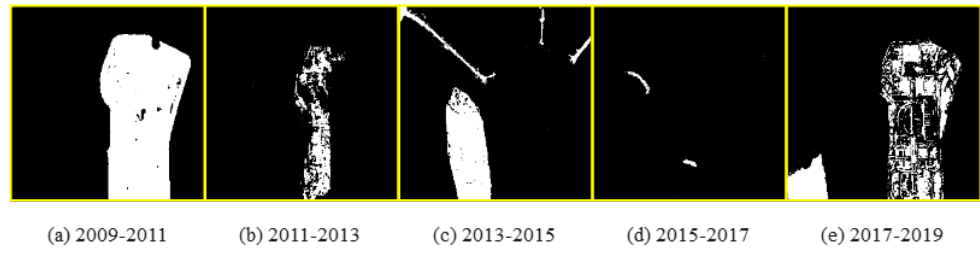
Figure 9. The long time series change map of